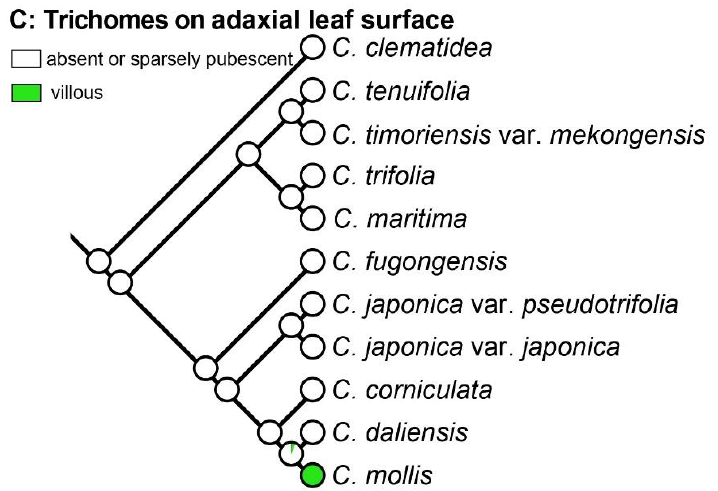
Figure 4. Character optimization of trichomes using the maximum likelihood approach based on the Mk1 model implemented in Mesquite. ( A ) Trichomes on branchlets. ( B ) Trichomes on abaxial leaf surface. ( C ) Trichomes on adaxial leaf surface. Pie charts show each character ’ s ML support at its ancestral nodes.